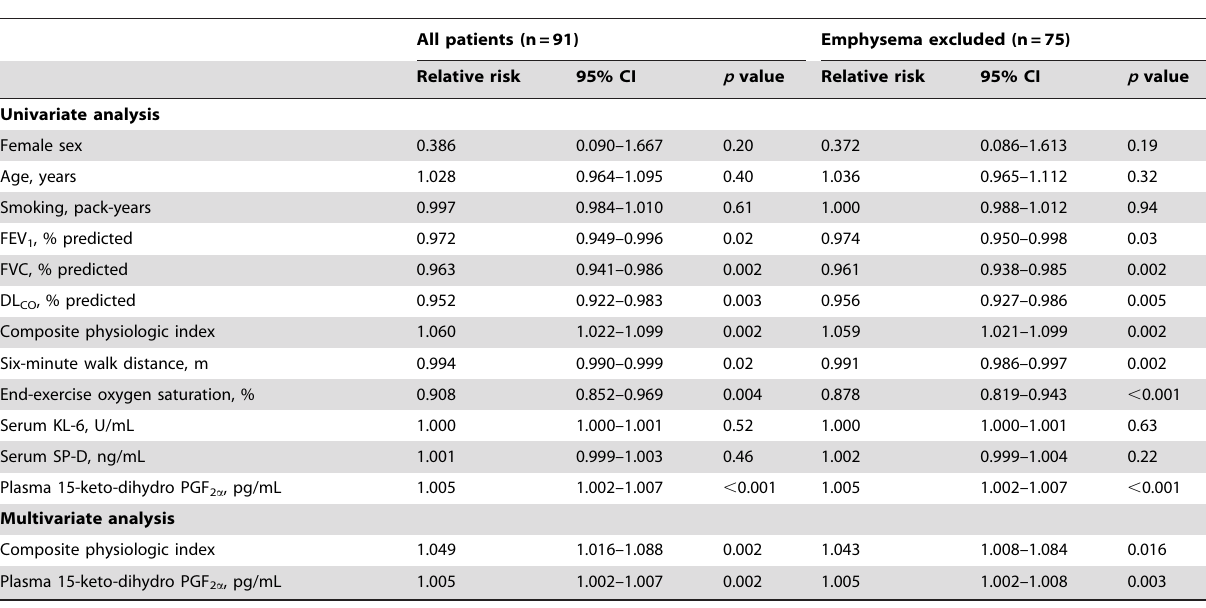
Table 3. Cox proportional hazard model results for evaluating the risk of mortality.